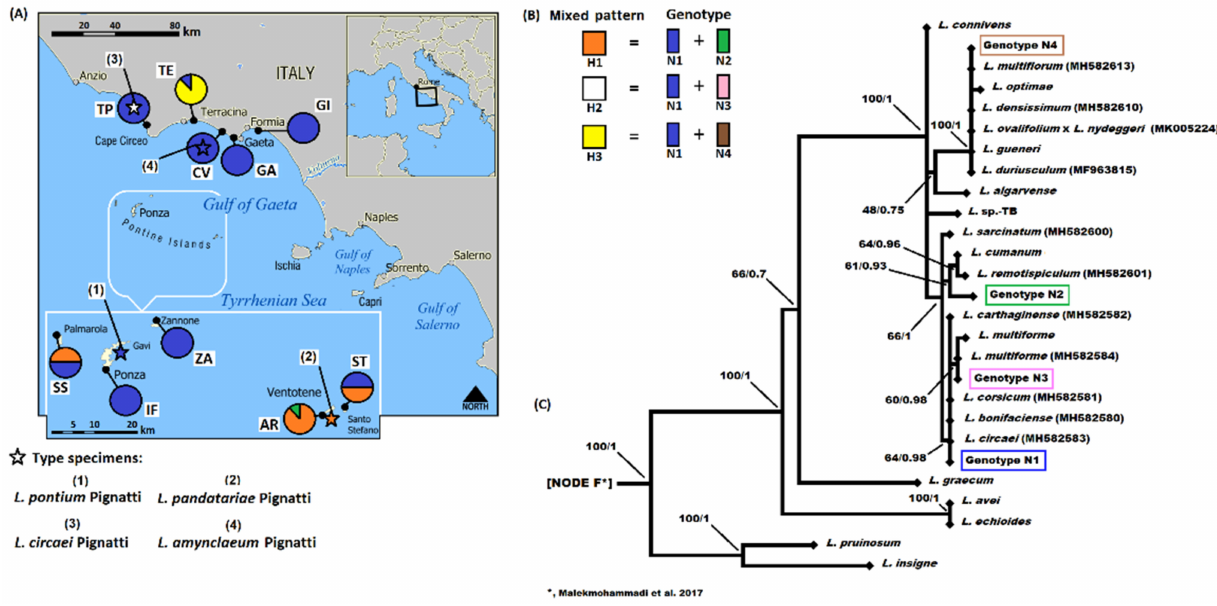
Figure 3. ( A ) The ten localities of the investigated Limonium populations (80 individuals) and the corresponding genotypes (single and mixed) obtained with the ITS markers (nrDNA). Type specimens for four Limonium species analyzed are reported as star symbols with numeric legend. ( B ) Information is also shown for their genotypes and ( C ) corresponding phylogenetic position in the maximum likelihood (ML) tree (a detail of phylogram is shown). Same topology was observed in the Bayesian inference (BI). The dataset of Malekmohammadi et al. [4] has been used in the phylogenetic analysis, the taxa with GenBank numbers in parentheses do not belong to the Malekmohammadi et al. dataset. Node F corresponds to the node of “ L. graecum clade” present in Figure 3 of Malekmo- hammadi et al. [4]. ML bootstrap values followed by the Bayesian posterior probabilities are shown below the branches (values >50%). Codes correspond to the population localities shown in Table 1; colored symbols correspond to the genotypes (N1–N3) shown in Table 2. After the BLASTn analyses, the identity of the single ITS genotypes was N1 = 100% (query cover 95%) with L. circaei (GenBank: MH582583), L. carthaginense (Rouy) C.E.Hubb. & Sandwith (MH582582), L. corsicum Erben (MH582581), and L. bonifaciense Arrigoni & Diana (MH582580); N2 = 99.19% (q.c. 93%) with L. cumanum (Ten.) Kuntze (JX983717) and 99.05% (q.c. 95%) with L. saracinatum R.Artelari (MH582600); N3 = 100% (q.c. 95%) with L. multiforme Pignatti (MH582584); and N4 = 100% (q.c. 100%) with L. duriusculum (Girard) Fourr. p.p. (MF963815), (q.c. 96%) L. densissimum (Pignatti) Pignatti (MH582610), (q.c. 95%) L. gueneri Dogan, Duman & Akaydı (MF041873), and (q.c. 95%) off-spring of L. ovalifolium (Poir.) Kuntze x L. nydeggeri Erben